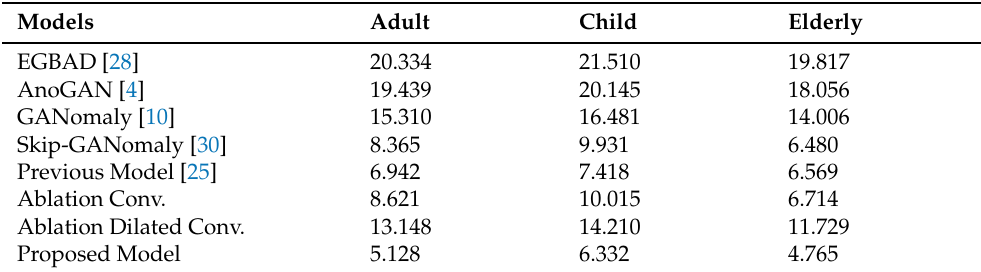
Table 4. FID score comparison for three different classes (Adult, Child, and Elderly) for the benchmark models, the proposed model, and the ablation study of the proposed model. Note that a lower score generally means better performance.